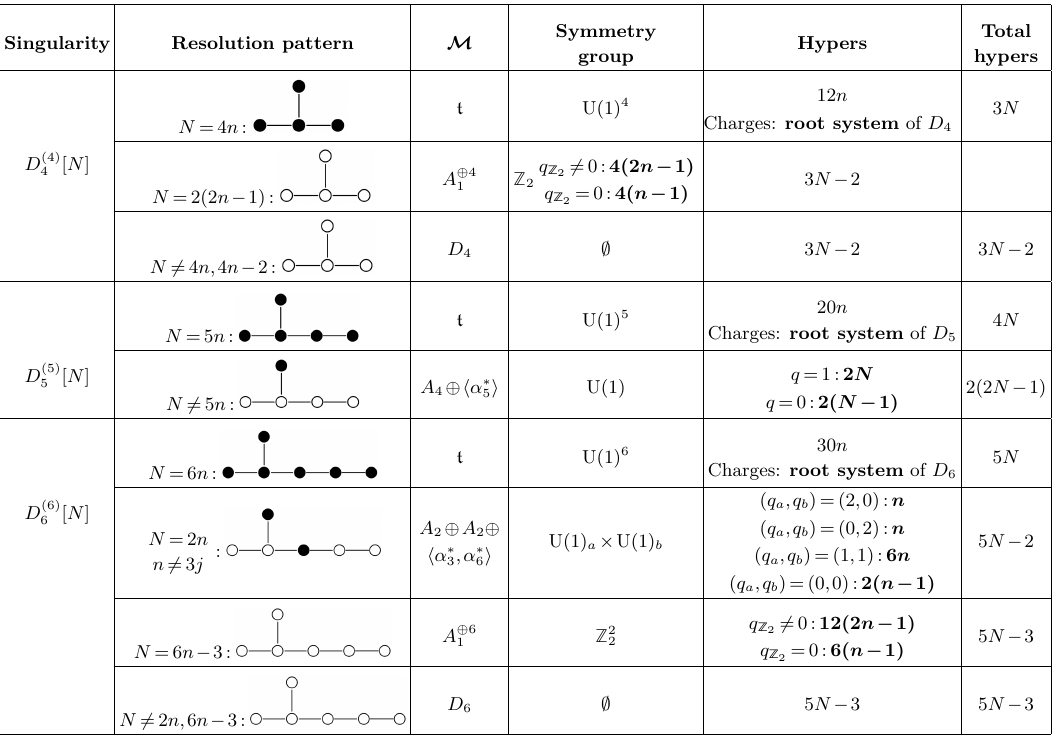
[ N ] , D (5) [ N ] , D (6) [ N ] 4 5 6